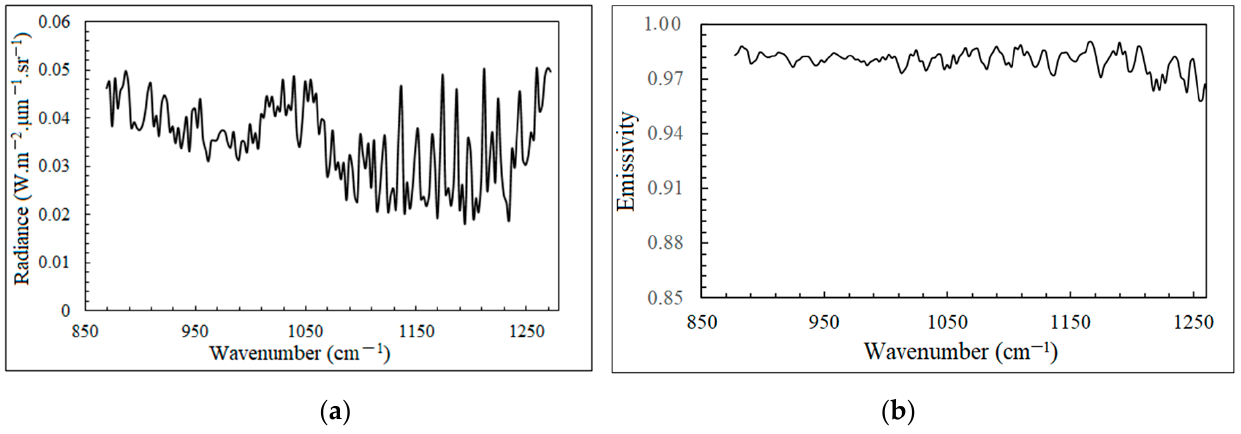
Figure 21. Temperature of Polygonum divaricatum.